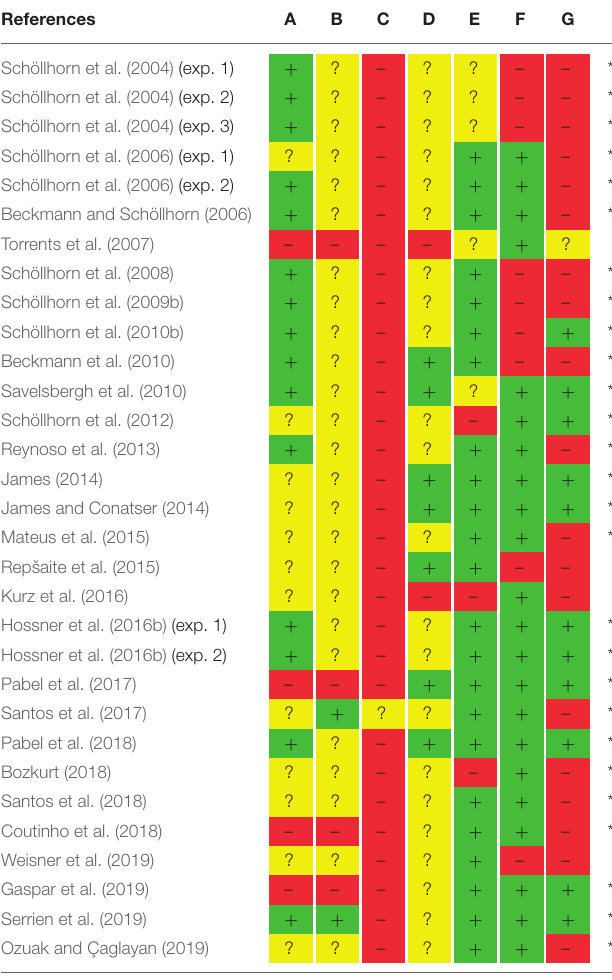
TABLE 2 | Risk of bias